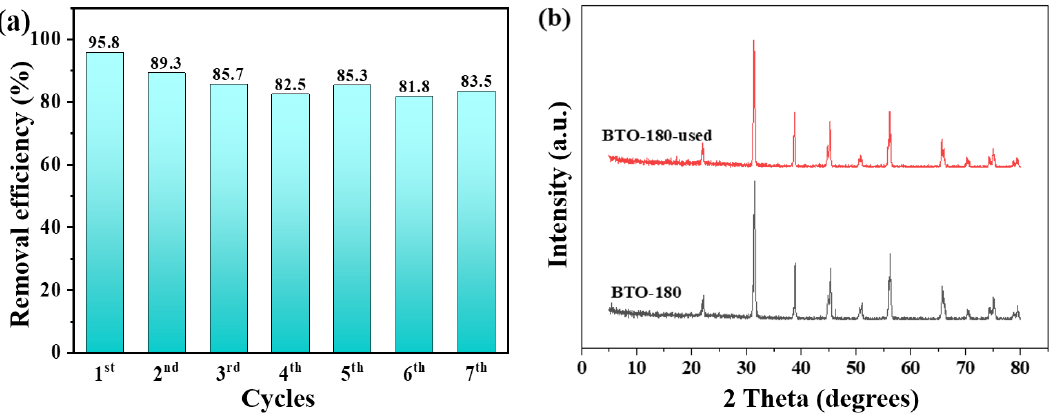
Figure 5. ( a ) The reusability of the BTO-180 piezocatalyst for the treatment of RhB. ( b ) XRD patterns of the BTO-180 sample before and after use.